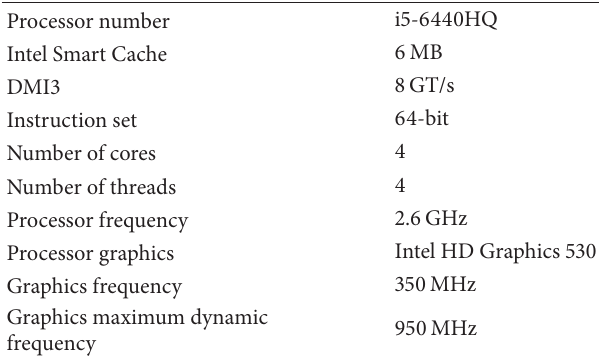
Table 3: CPU and GPU configurations